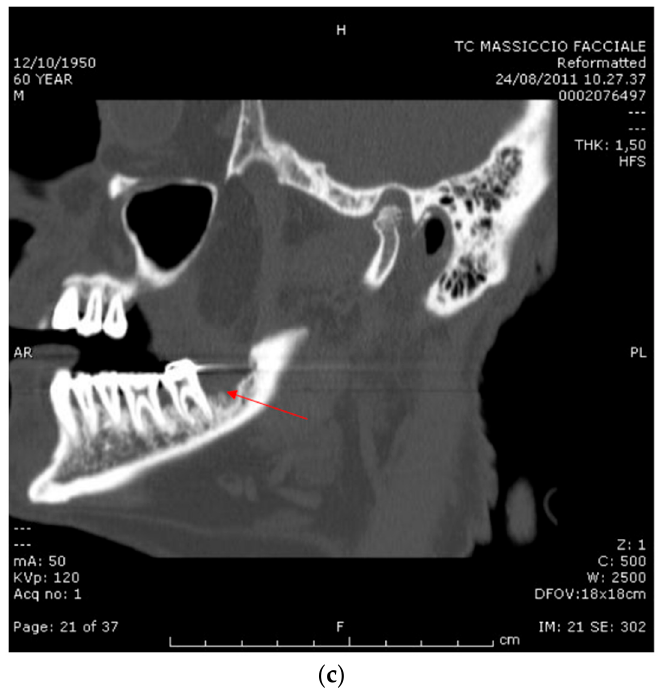
Figure 6. Case 2: CT scan images of the mandible post-extractive socket. ( a ) Coronal formatting; ( b ) Panorex; ( c ) Sagittal formatting that shows the bone sequestrum.